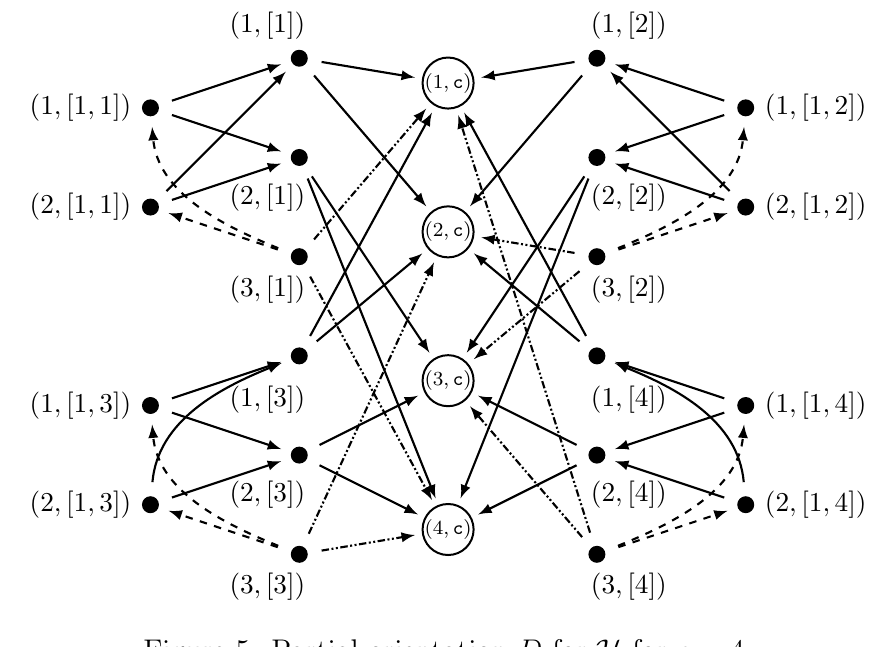
Figure 5: Partial orientation D for H for s = 4,